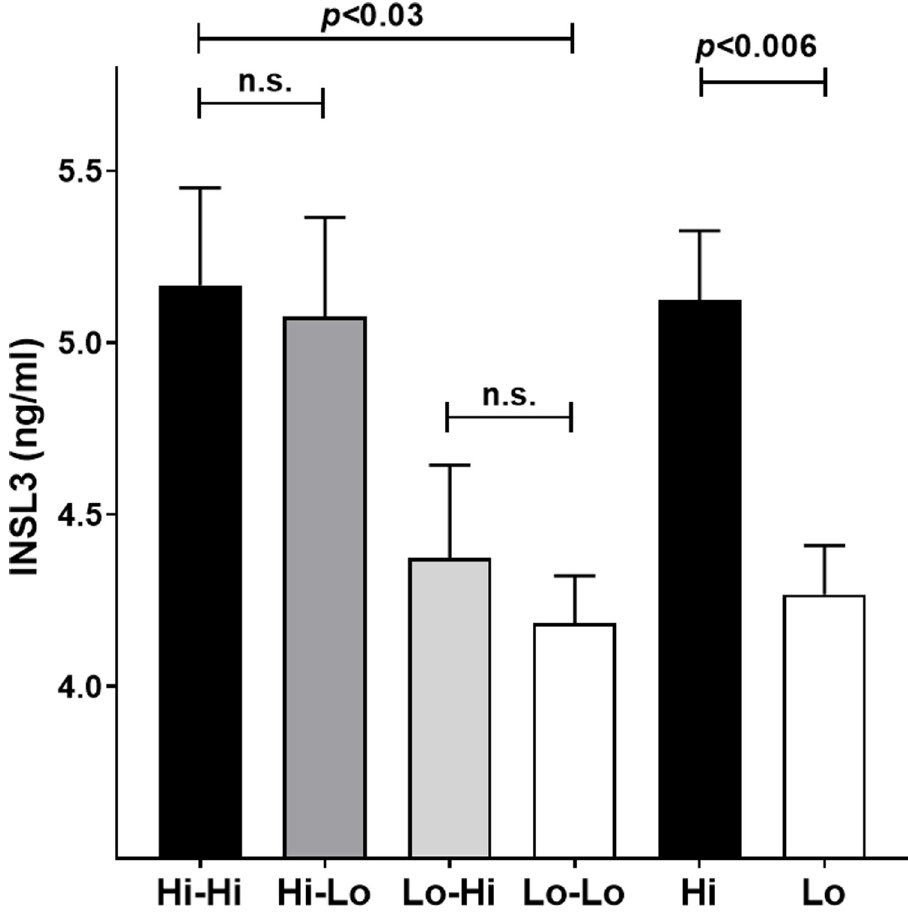
Fig 2. Average INSL3 concentration at months 8 to 10. Holstein bull calves were fed either a high (Hi-Hi) or low (Lo-Lo) plane of nutrition throughout, or had the nutritional paradigm reversed at 6 months to create Hi-Lo or Lo-Hi groups, as indicated. Hi or Lo, represent the combined INSL3 concentration for all animals fed either a high (Hi) or low (Lo) plane of nutrition in the first 6 months, irrespective of the later feeding regimen. Data are given as ng/ml (means ± SEM); n.s., not